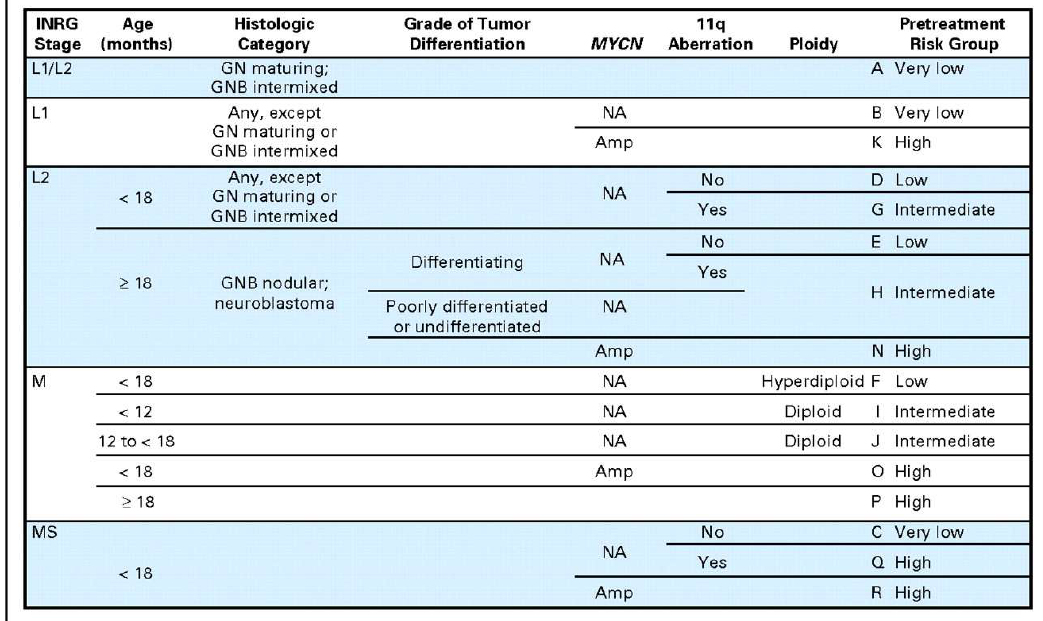
Figure 2. International Neuroblastoma Risk Group (INRG) classification system [4]. Reprinted with permission from American Society of Clinical Oncology © 2009, The International Neuroblastoma Risk Group (INRG) Classification System: An INRG Task Force Report; published by American Society of Clinical Oncology, 2009.